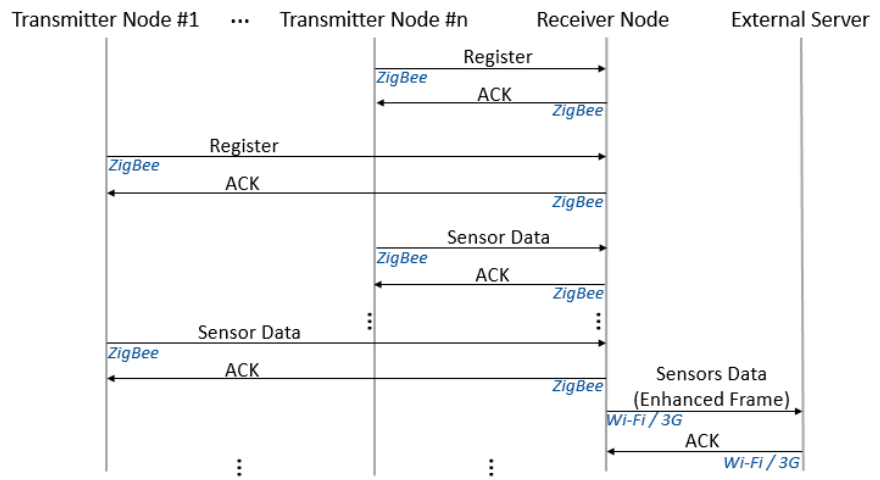
Figure 5. Simplified protocol message flow diagram for the local mode.